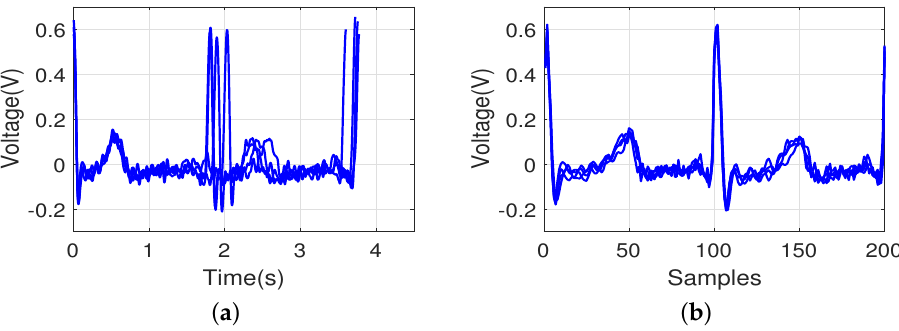
Figure 6. Example of an ECG pattern, including two heartbeats, shown by an overlapping of four different consecutive heartbeats: ( a ) original signal between the R-R-R fiducial points; ( b ) signal after re-sampling to a 200-point